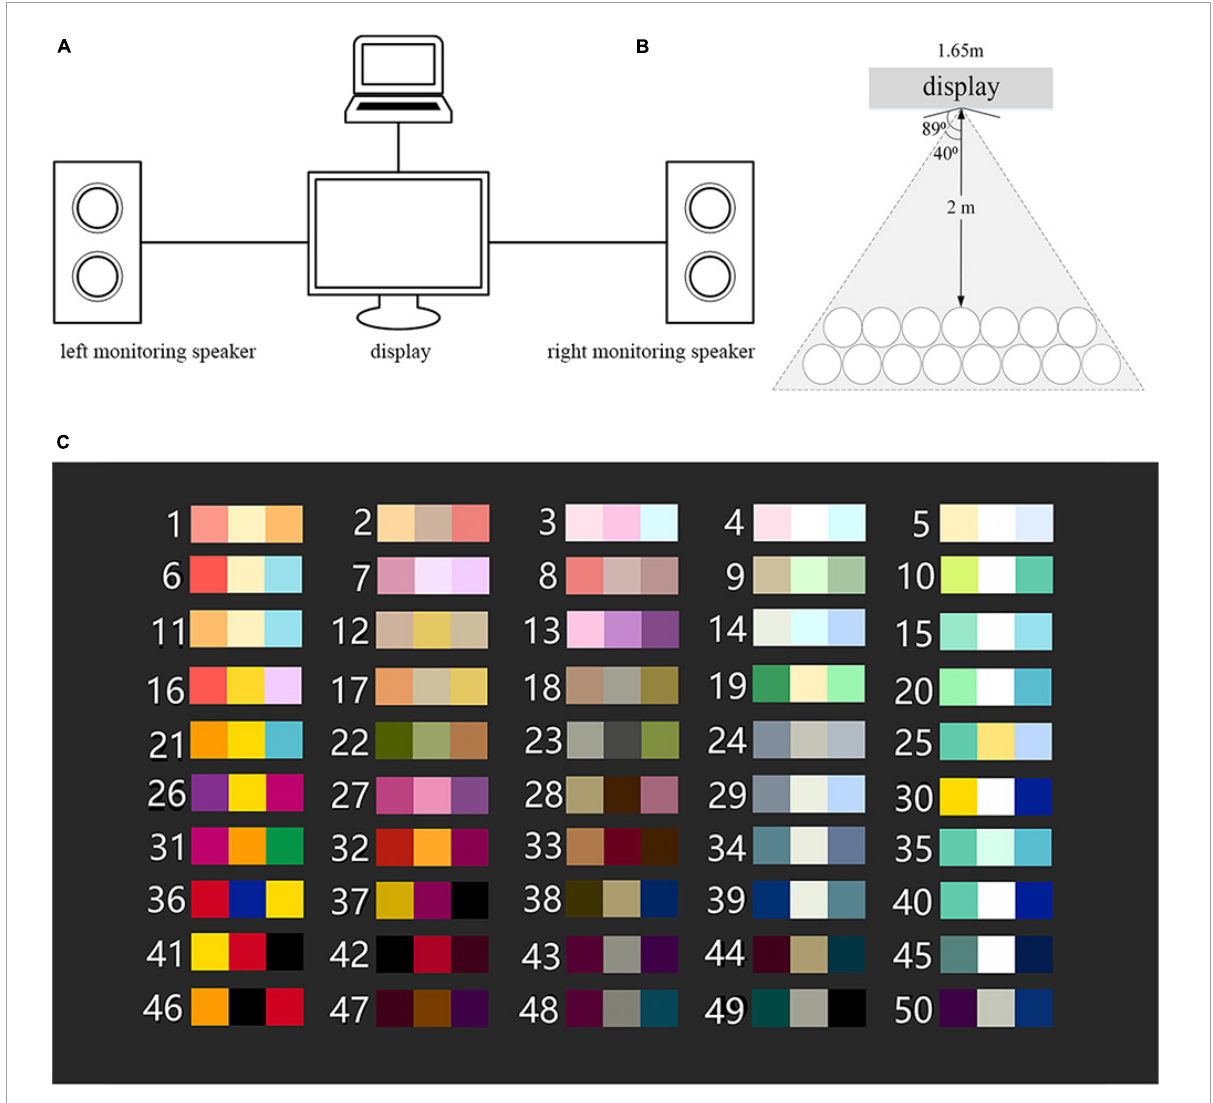
FIGURE3 The experimental condition. (A) The connection of the experimental system. (B) The arrangement of seats. (C) The presentation of the multi-color